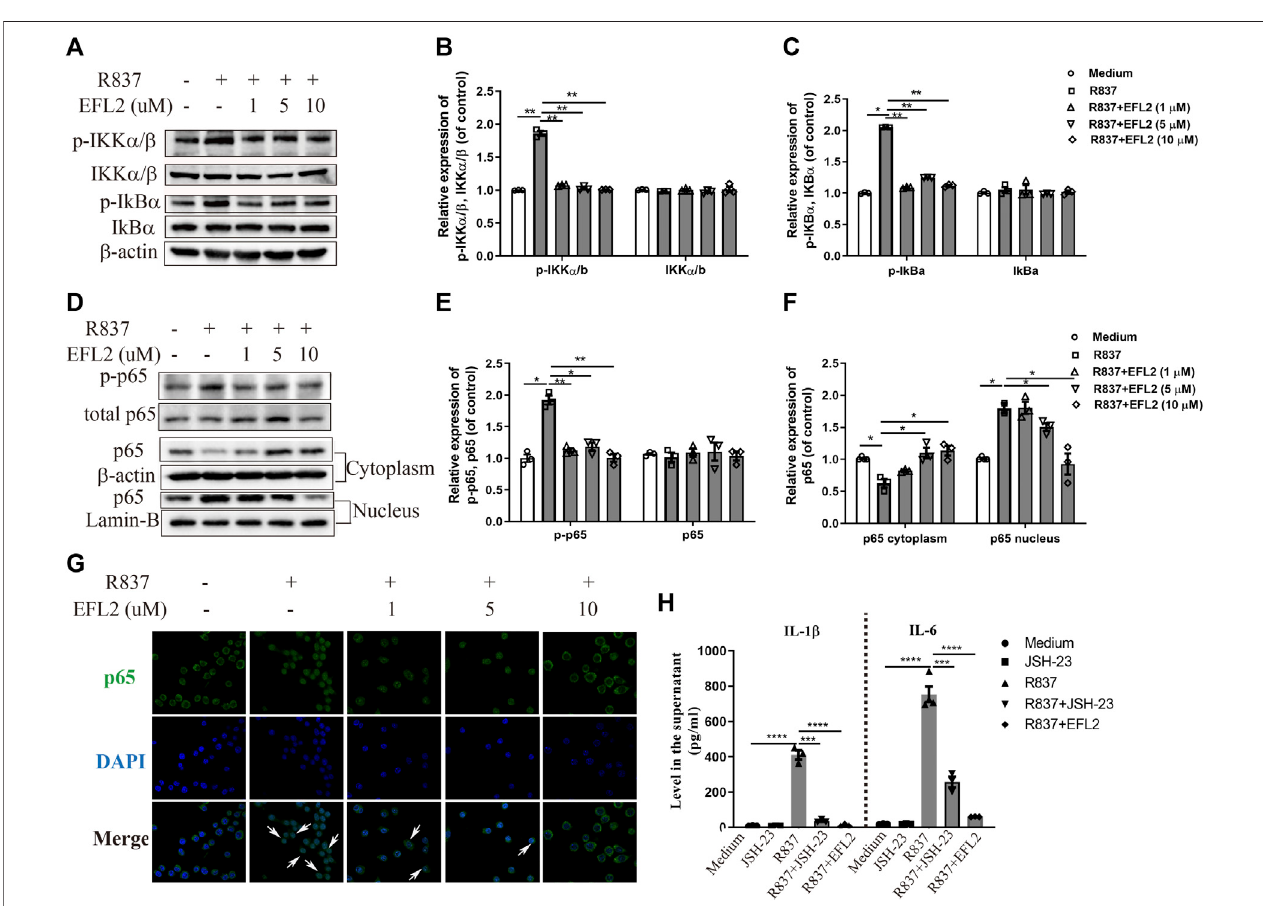
FIGURE 6 | EFL2 inhibited the NF- κ B signaling pathway activation. RAW264.7 cells were incubated with different concentrations of EFL2 (1, 5 and 10 μ M) for 1 h, followedbyR837(20 μ g/ml)stimulationfor30min,thenharvestedforwesternblottinganalysis (A – C) Westernblotbands (A) andquanti fi cationof p -IKK α / β ,IKK α / β (B) , p -IkB α and IkB α (C) in RAW 264.7 cells (D – F) Western blot bands (D) and quanti fi cation of p-p65 (E) and p65 expression in cytoplasm and nucleus (F) in RAW 264.7 cells (G) p65localizationdetermined byimmuno fl uorescencestaining(Magni fi cation: × 40) (H) EffectofNF- κ Binhibitor onR837-induced IL-1 β andIL-6production (n (cid:1) 3 for each group in an independent experiment). Data represent the mean values ± SEM of three independent experiments. * p < 0.05, ** p < 0.01, *** p < 0.01, *** p < 0.01 were considered as signi fi cant.